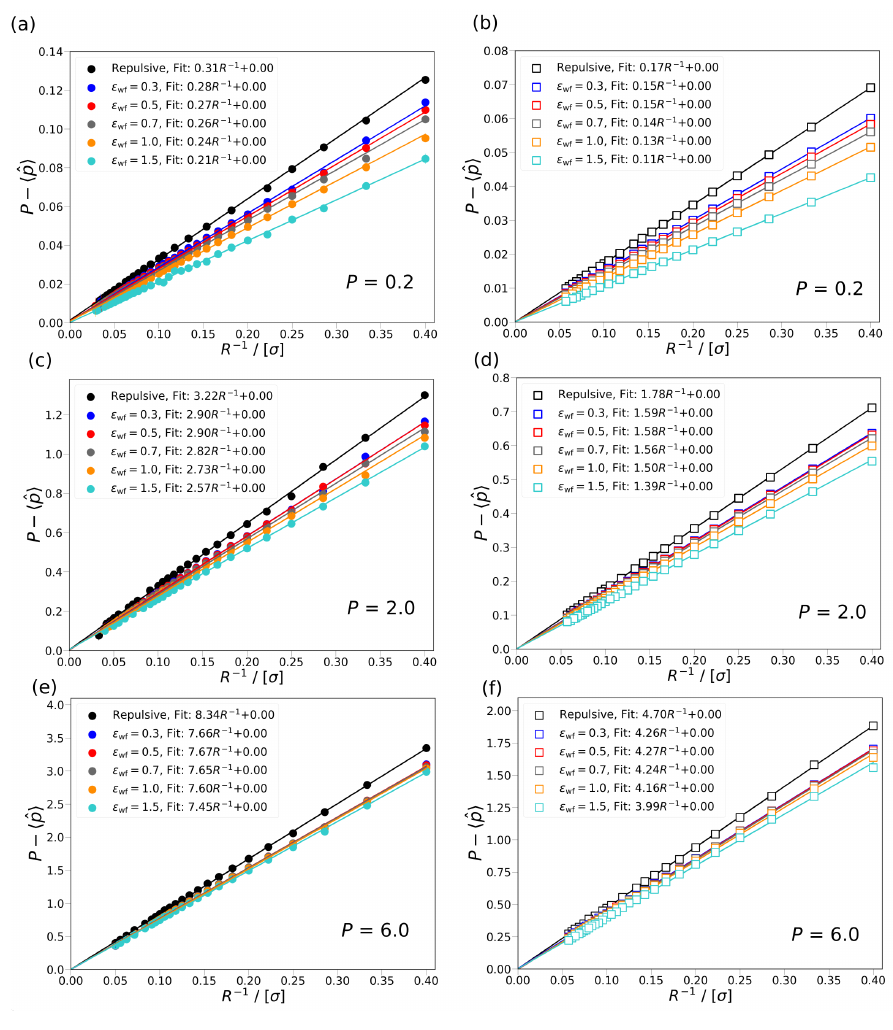
Figure 4. The difference between the differential, P , and the ensemble average of integral pressure, (cid:104) ˆ p (cid:105) , is shown as a function of the inverse radius R − 1 of Box 2 at P = 0.2, 2.0, and 6.0 for cylindrical and slit pores with fluid-wall interactions. ( a , c , e ) The pressure difference is shown for cylindrical pores at differential pressure P = 0.2, 2.0, and 6.0, respectively. ( b , d , f ) The pressure difference is shown for slit pores at differential pressure P = 0.2, 2.0, and 6.0, respectively. The simulation results are shown with symbols, while the lines are fits to the data points. The equation used for the fitting is AR − 1 + B , where A and B are constants. The colors denote the different level of attraction between the wall of Box 2 and the fluid, repulsive wall potential (black), (cid:101) wf = 0.3 (blue), 0.5 (red), 0.7 (gray), 1.0 (orange), and 1.5 (cyan). The results for the cylindrical pore are shown with closed circles and for the slit pores with open rectangles. The temperature of both boxes is set to T = 2. The average densities of Box 1 are ρ ≈ 0.10, 0.58, and 0.8 at P = 0.2, 2.0, and 6.0,